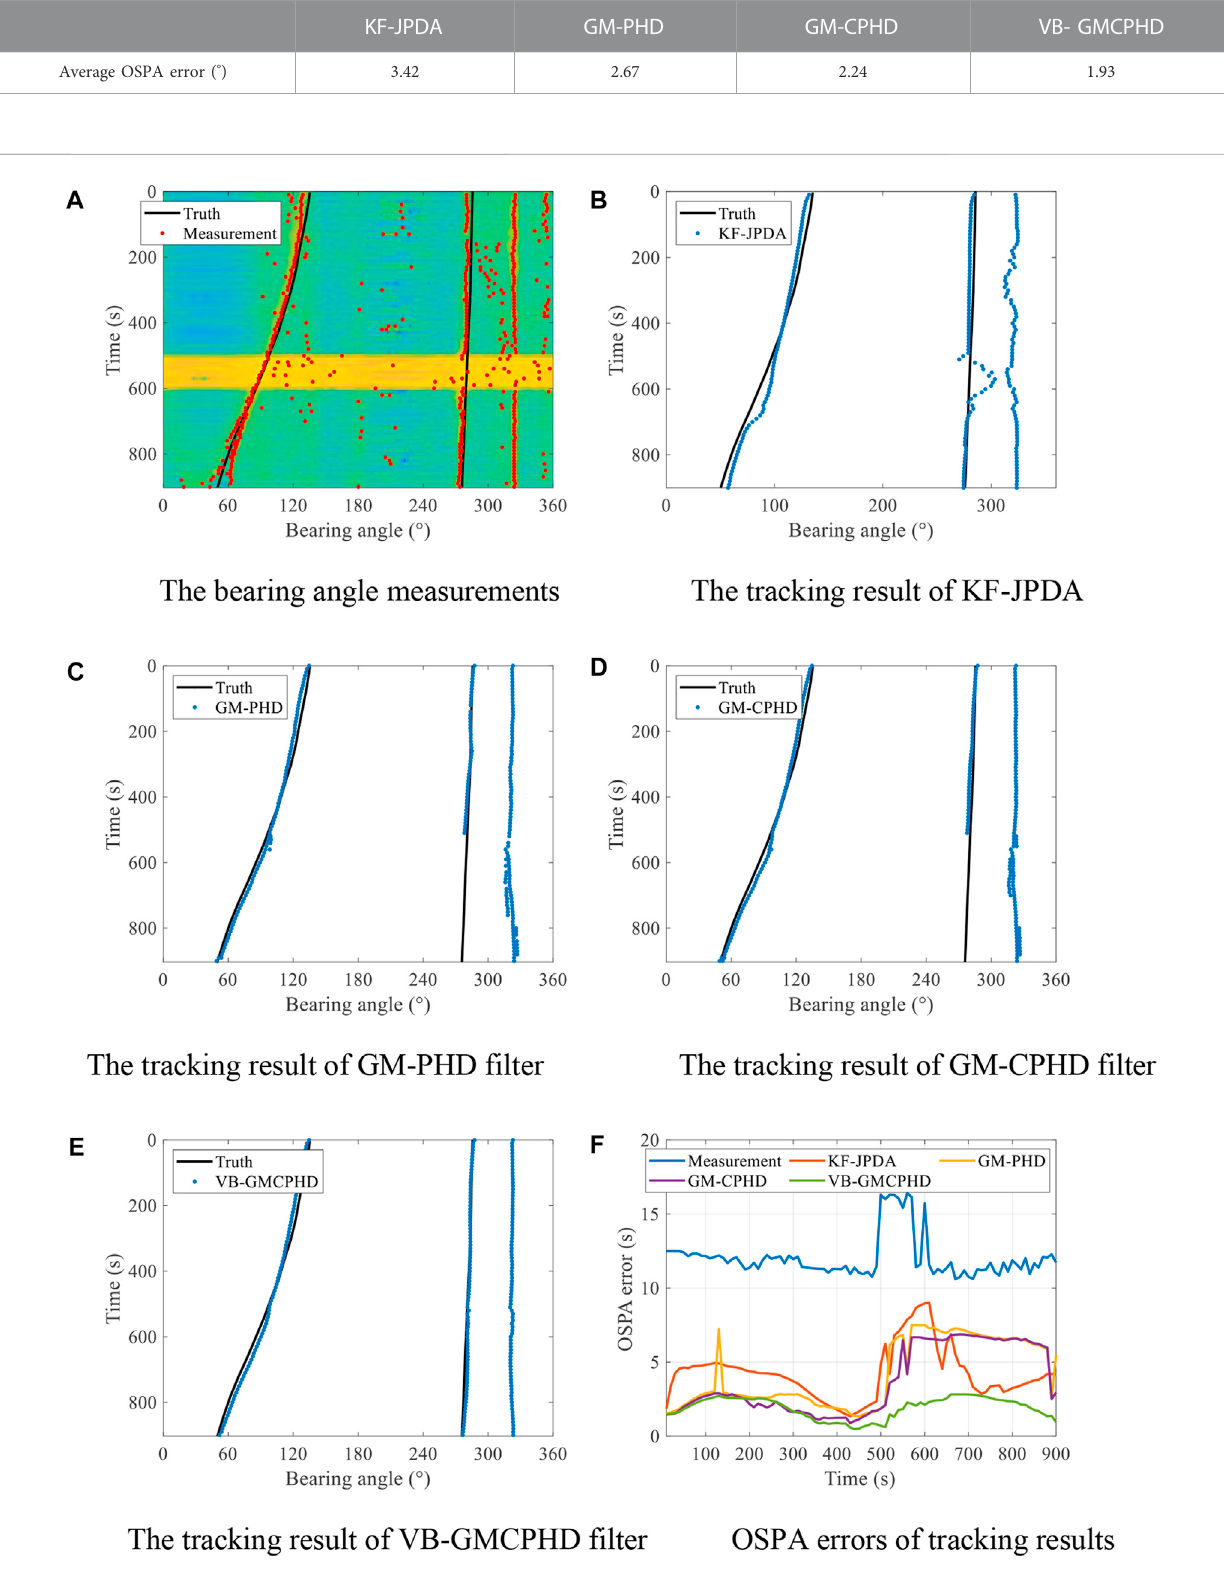
FIGURE 3 Bearing angle measurements, tracking results, and OSPA errors of KF-JPDA, GM-PHD fi lter, GM-CPHD fi lter, and VB-GMCPHD fi lter when processingtheexperimentaldatawithaddednoise. (A) Bearinganglemeasurements. (B) TrackingresultofKF-JPDA. (C) TrackingresultofGM-PHD fi lter. (D) Tracking result of GM-CPHD fi lter. (E) Tracking result of VB-GMCPHD fi lter. (F) OSPA errors of tracking